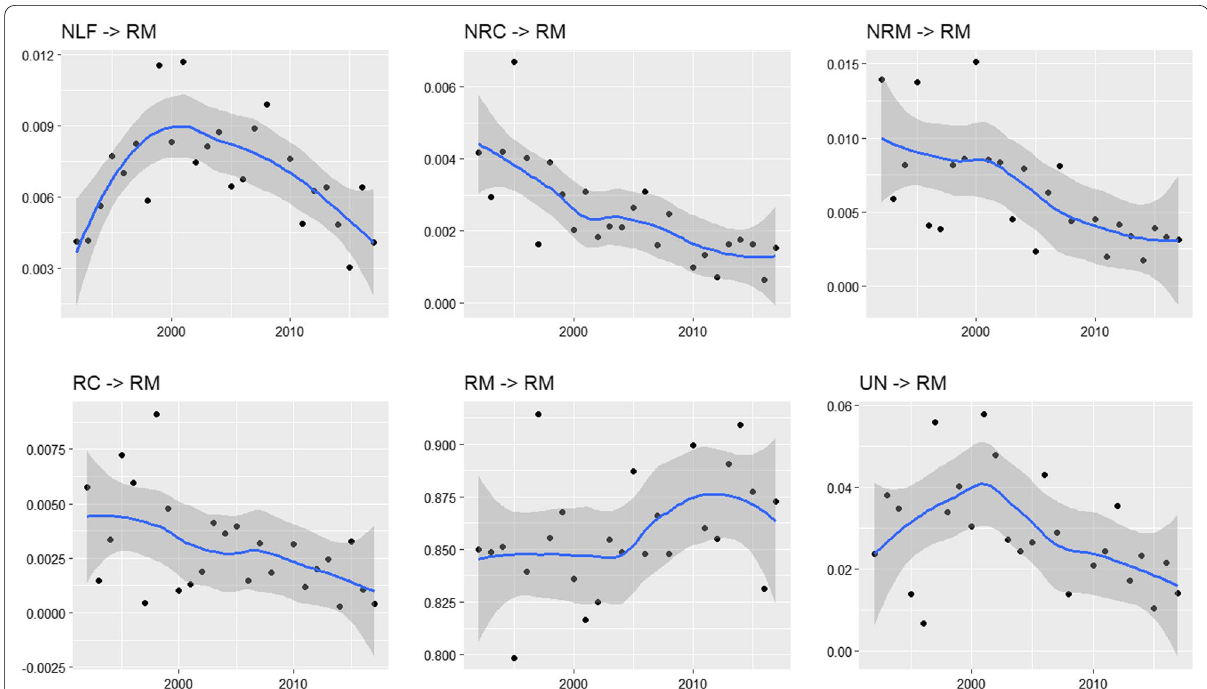
Fig. 2 Transition Rates for Inflows into Routine Manual Jobs. Notes: Transition rate computation is explained in chapter 3.2, blue lines show local regression lines, and the gray area marks the 95% confidence interval. The figure also includes the stayer rate (RM → RM), the share of routine manual workers remaining in routine manual employment. Transition rates for RC, NRM and NRC employment are provided in Appendix Figs. 5, 6 and 7. Source: Swiss Labour Force Survey,